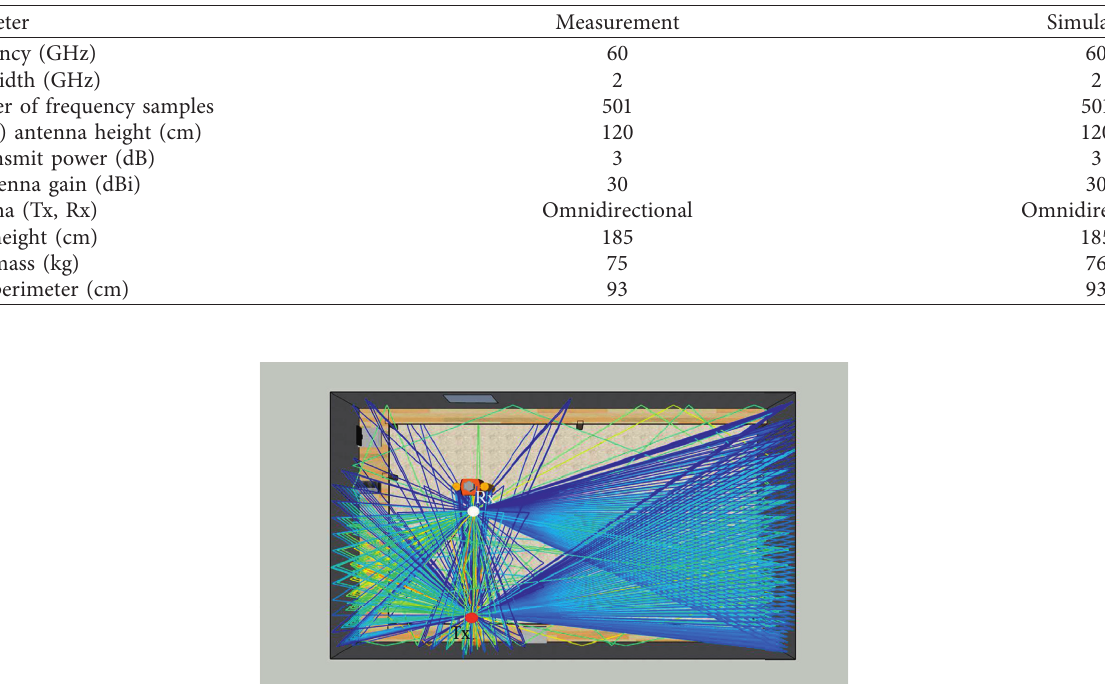
Table 18: The configurations for scenario II.